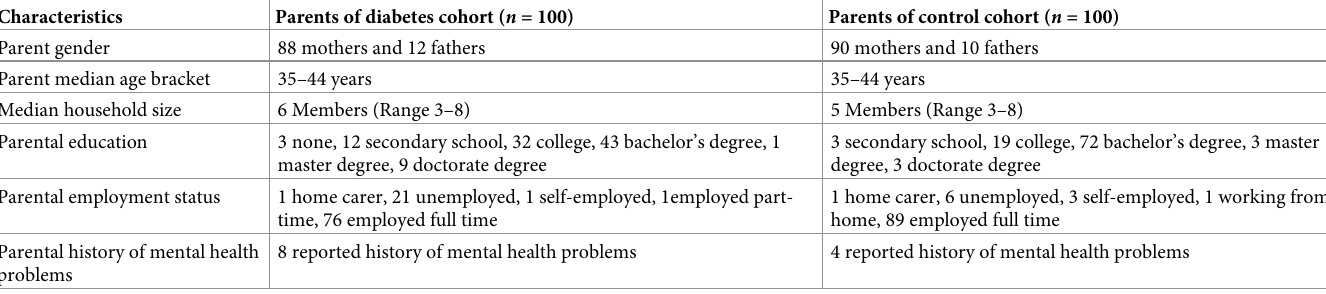
Table 2. Demographic and clinical characteristics of